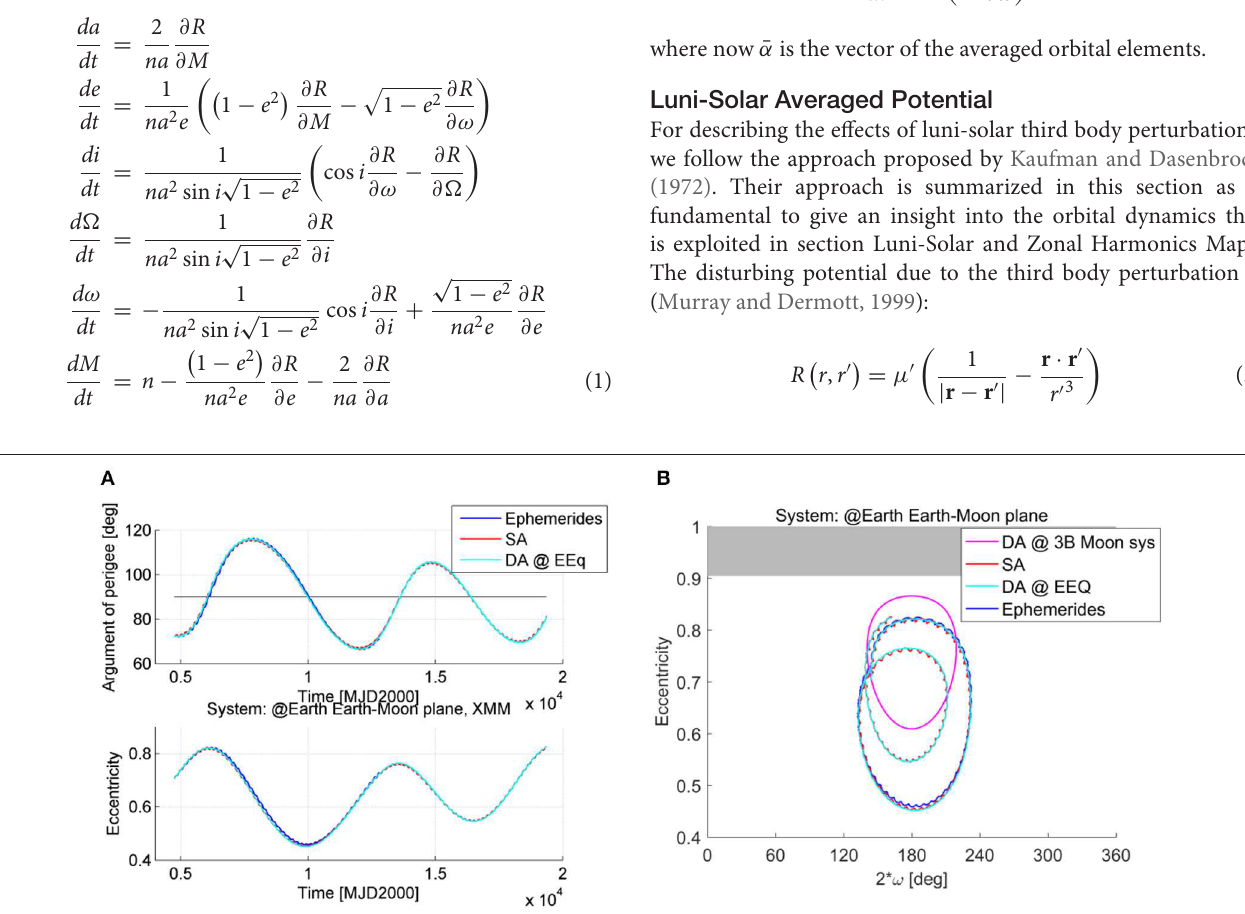
FIGURE 3 | Evolution of a high altitude orbit under the effect of luni-solar and zonal perturbations. (A) Comparison of the actual ephemerides (blue) with single averaged (red) and double averaged (cyan) dynamics. (B) Evolution in the eccentricity-2 ω phase space, where the argument of the perigee is measured with respect to the Moon